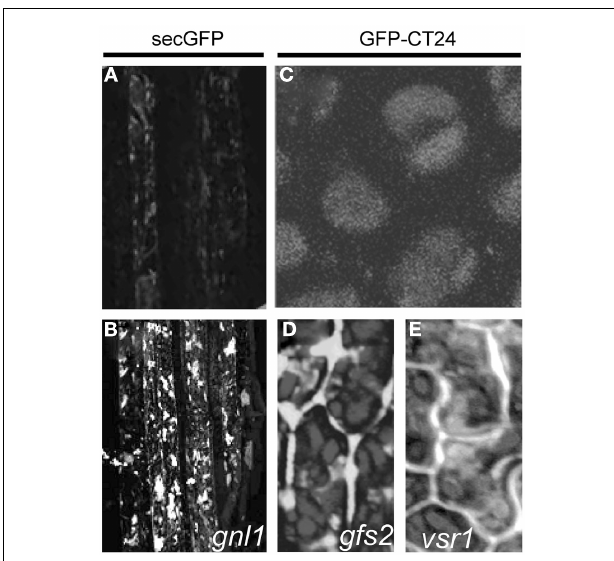
FIGURE 1 | Cellular phenotype of the mutants selected based on the presence of fluorescent signal. Arabidopsis secGFP transgenic line (A) showing weak fluorescence of secreted GFP and (B) pronounced signal accumulation in the root cells of gnl1 mutant. Adapted fromTeh and Moore (2007).Wild type GFP–CT24 seeds (C) , with the vacuole-targeted marker, signal completely merged with the autofluorescence of PSVs. Mistargeting and secretion into the extracellular space of GFP–CT24 in gfs2 (D) and vsr1 (E) mutant seeds. Adapted from Fuji et al.